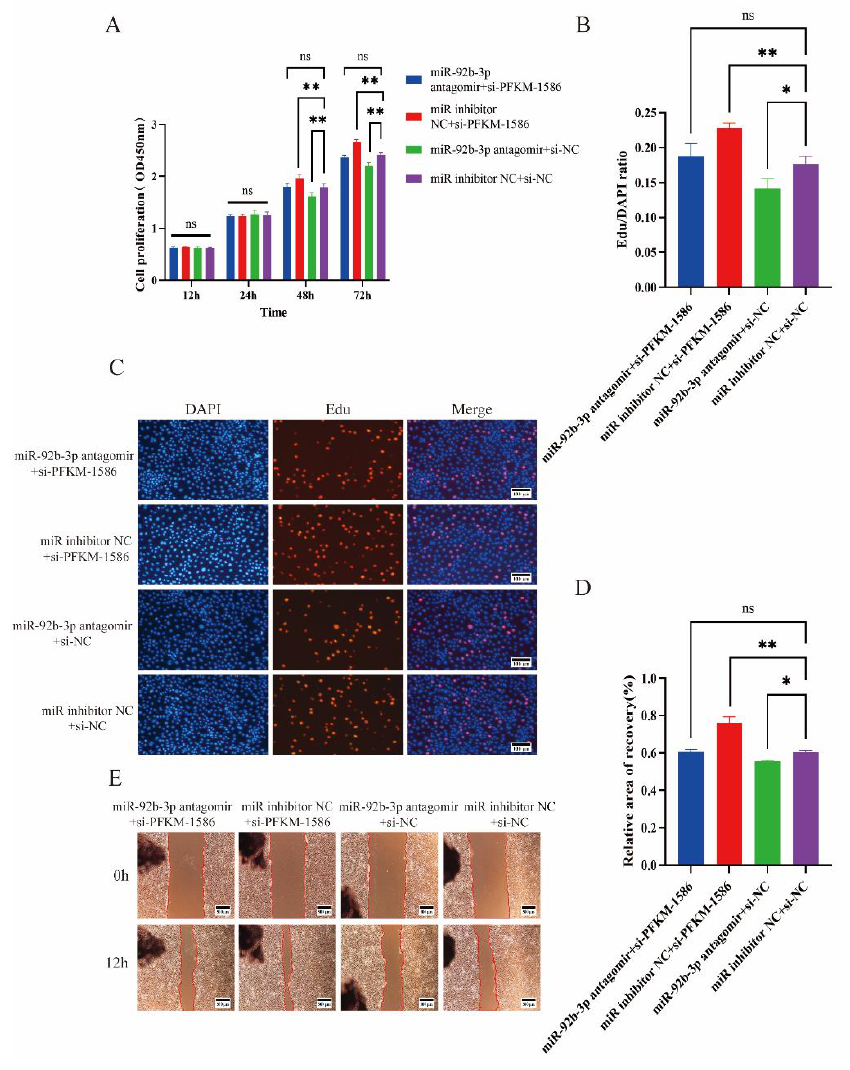
Figure 5. Knockdown of PFKM can rescue the effect of miR-92b-3p antagomir on the proliferation and migration of PTr2. ( A – C ) si- PFKM -1586 reversed the proliferation of PTr2 inhibited by miR-92b-3p antagomir. ( D , E ) The reduced number of cell migrations caused by antago-miR-92b-3p was partially rescued by si- PFKM -1586. Data are the means ± SEM of three experiments. (ns: no significant difference; * p < 0.05; ** p <